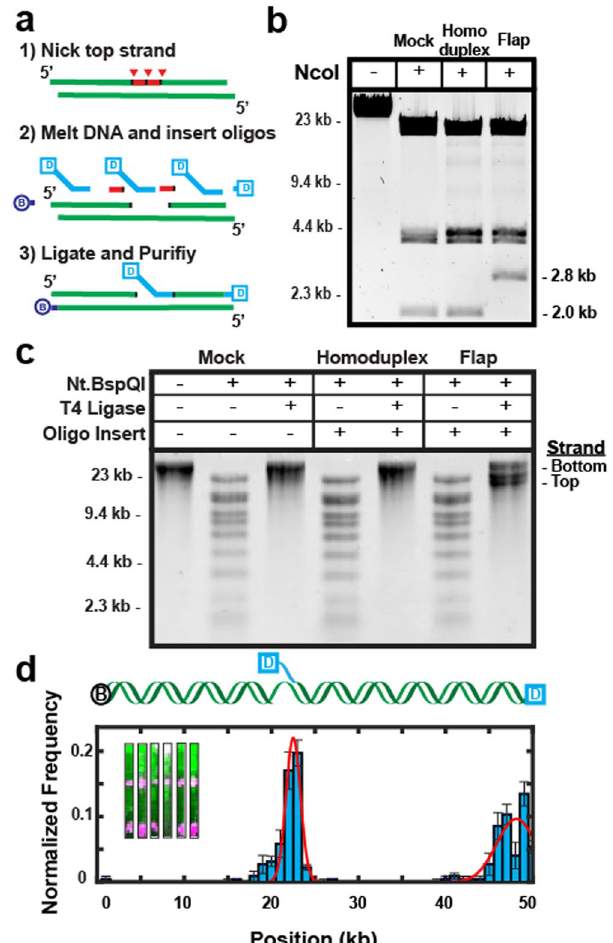
Figure 3. Construction of DNA substrates containing extrahelical structures. ( a ) Schematic of nickase- mediated insertion of a synthetic oligonucleotide (Digoxigenin (dig)-labeled 5 ′ -flap). ( b ) Diagnostic digest of a recombineered λ , demonstrated here by the 2.8 kb band in lane 4 which is digested into two smaller bands in lanes 2 and 3 (bottom band not shown). ( c ) Denaturing alkaline agarose gel of three separate reactions (a “mock-treated” DNA where the nicked DNA is replaced with a complementary oligo, a homoduplex DNA, and a 5 ′ -ssDNA flap) to determine ligation efficiency. The last lane shows a larger band (bottom strand) and two smaller bands (top strand) that are created upon insertion of the flap. ( d ) Top: schematic of a DNA substrate containing a dig-labeled 5 ′ -ssDNA flap and a dig-terminated free DNA end. Bottom: binding distribution of anti-dig quantum-dots to this DNA substrate. Solid lines indicate a double Gaussian fit to the data with the indicated mean ± standard deviation (5 ′ -ssDNA flap: 22 ± 0.8 kb; 3 ′ -DNA end: 47.5 ± 2 kb; N = 225). Insets: representative DNA molecules (green) labeled with quantum dots (magenta) at position A and at the free DNA